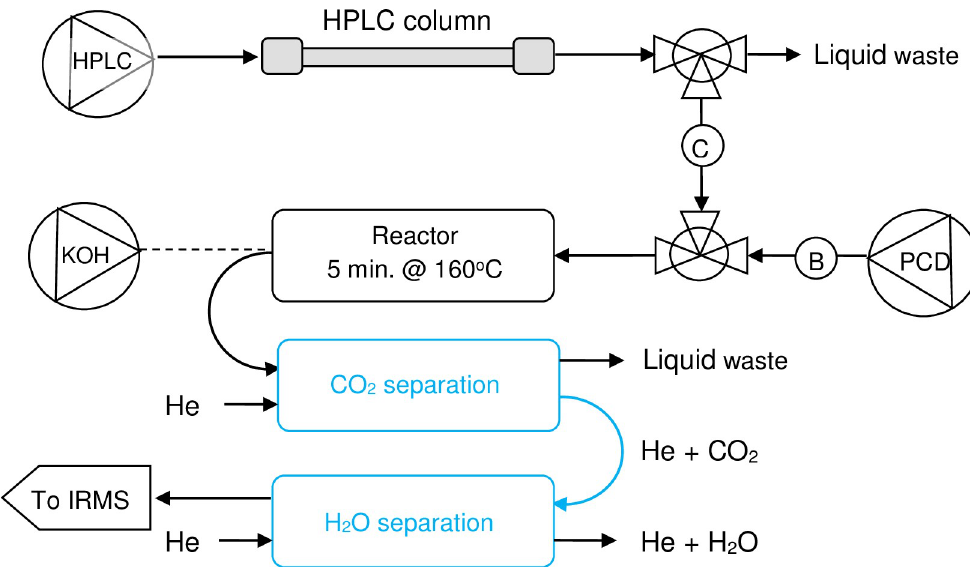
Fig 2. Schematic overview of the PSIA analytical instrument. Amino acids are separated by HPLC and a fraction of the eluent (150 from 750 μ l/min) is mixed 1:1 with acidic ninhydrin reagent prior to entering the 1.5 ml stainless steel coil at 160 o C. Amino acids are decarboxylated as part of the ninhydrin reaction and the carboxyl CO 2 is separated from the aqueous stream into a helium flow, dried and passed to an isotope ratio mass spectrometer to measure the carbon isotopic composition. B = back-pressure regulator, C = non-metallic check-valve. NB when the system is flushed with acetone (weekly) the connection between the CO 2 separator and H 2 O separator must be removed.